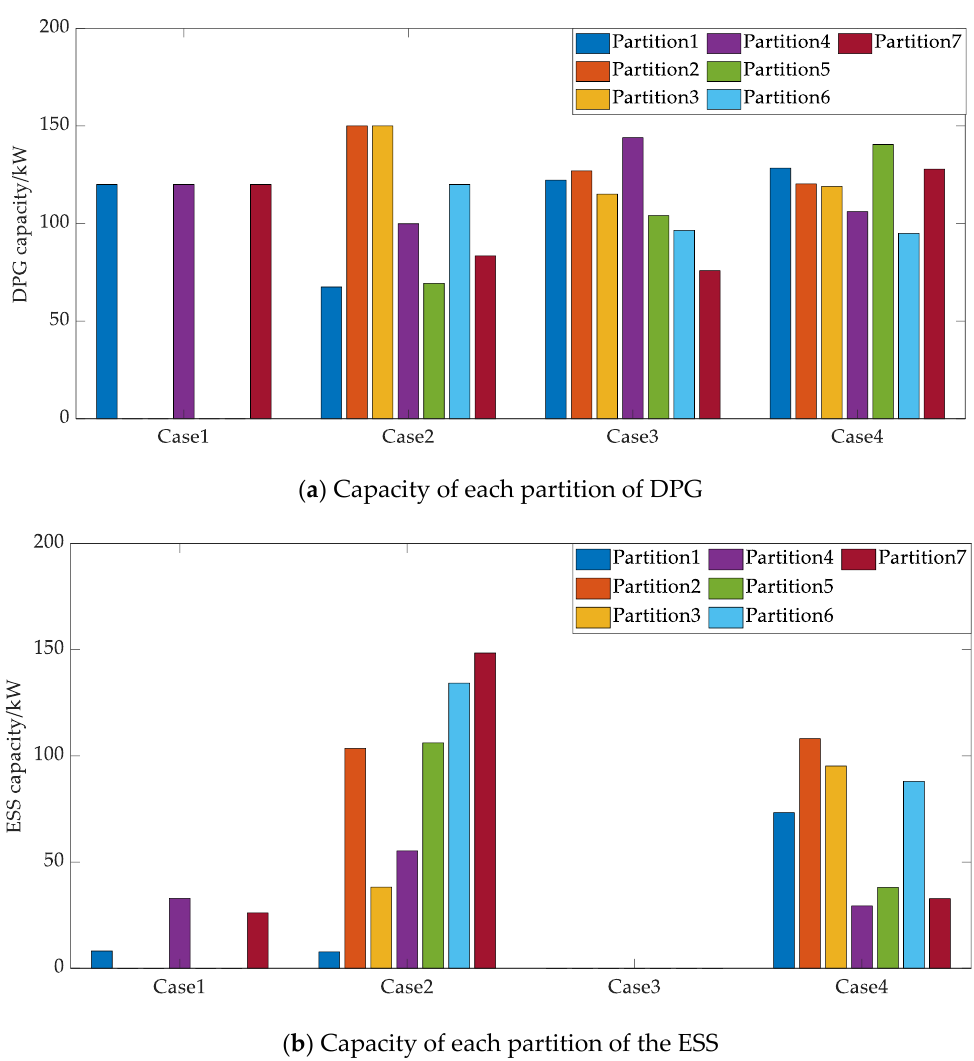
Figure 8. IEEE 33-bus distribution network partition results.